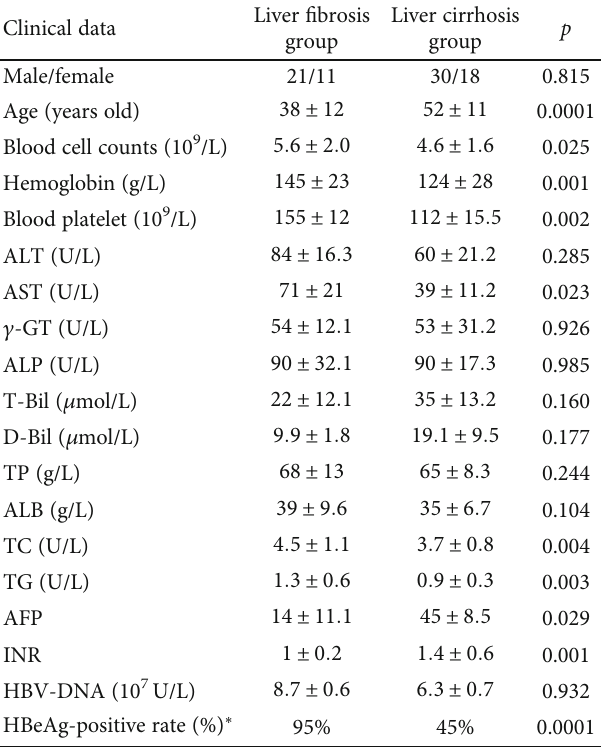
Table 3: Clinical characteristics of the CHB liver fi brosis and liver cirrhosis group cases ( (cid:1) x ± s ).